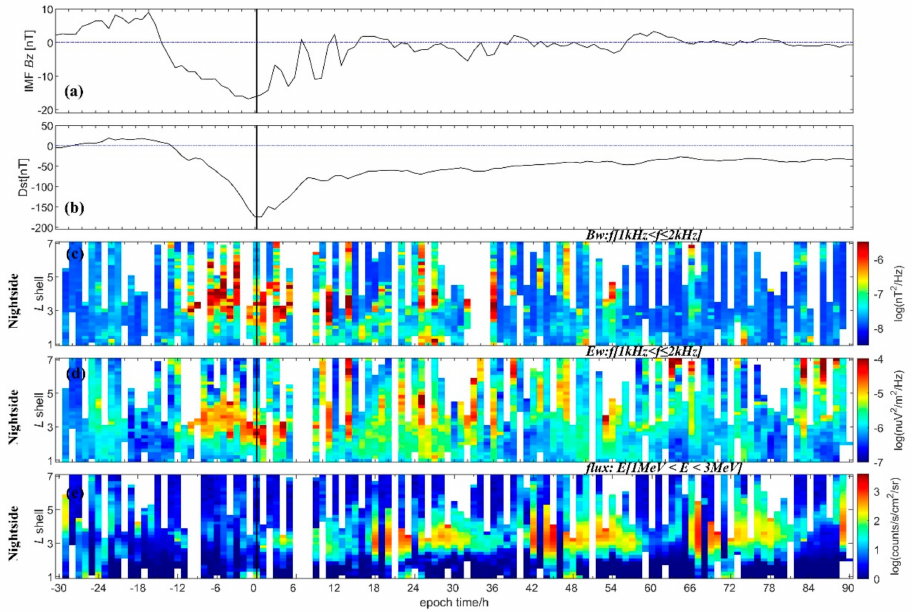
Figure 3. Same as Figure 2 but for the nightside